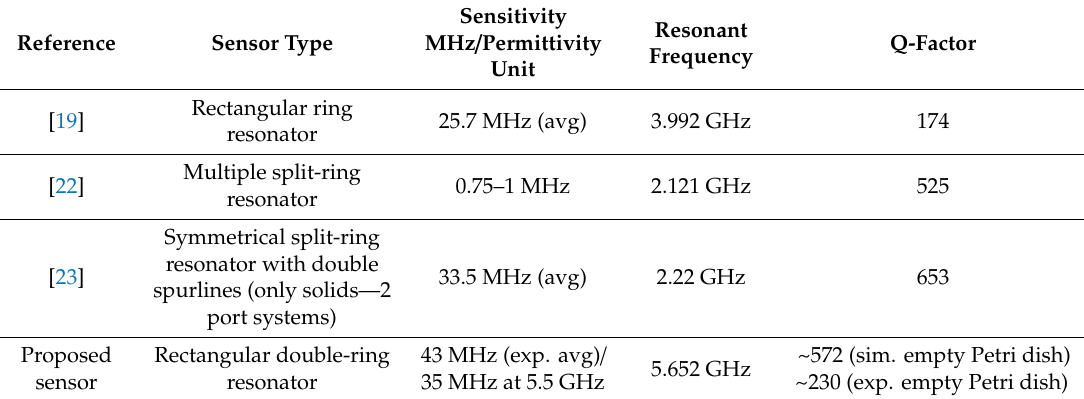
Table 3. Comparison between the proposed sensor and recently reported